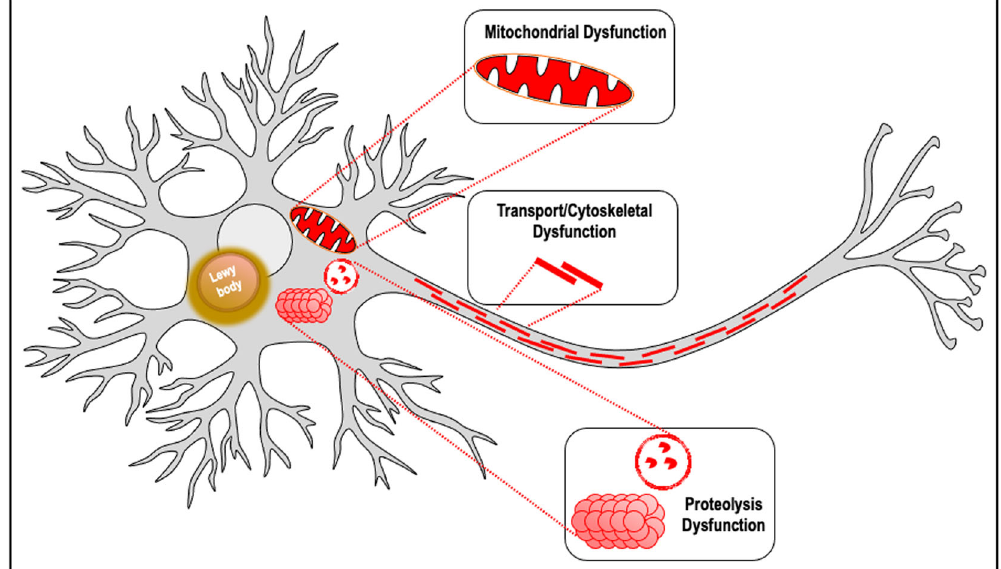
Fig. 1 Pathogenic mechanisms consistently associated with Lewy bodies across multiple approaches. Both immuno fl uorescence and LCM of LB-containing nigral neurons reveal alterations in proteolysis markers 25,36 as well as alterations in transport/cytoskeleton organization 27,36 . Some whole SN tissue analysis and LCM studies of nigral DA neurons also have detected proteolysis and transport/ cytoskeletal dysfunction 30 – 32,37,38 . Mitochondrial dysfunction is quite frequently detected by both whole SN tissue analysis and LCM approaches 30 – 32,38,39,145 however the association speci fi cally with LBs has not directly been